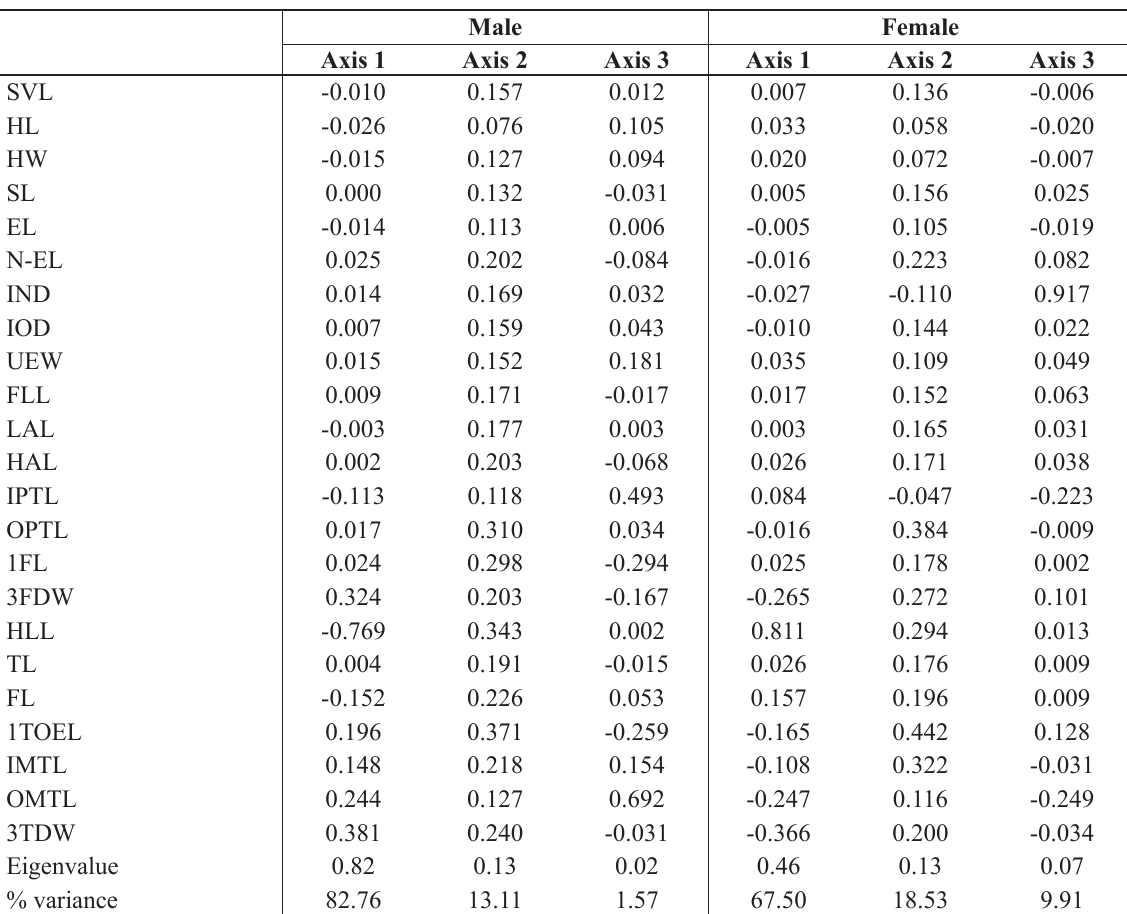
Table 4. Variable loadings for principal components with Eigenvalue greater than 0.01, from morphometric characters corrected by SVL. All measurements are given in millimeter (mm) of Microhyla